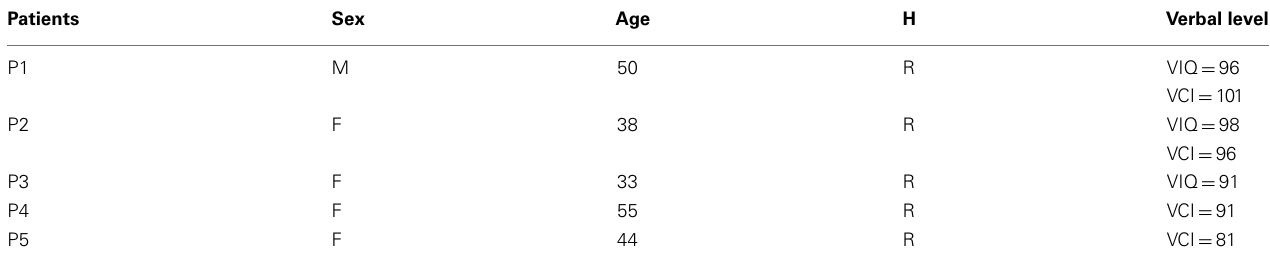
TableA1 |The table resumes several demographic data of patients P1–P5: sex (male, M; female, F); age (years old); handedness (H; right-handed, R); verbal scores (assessed withWAIS-III) showing either verbal IQ (VIQ) or verbal comprehension index (VCI), according to their